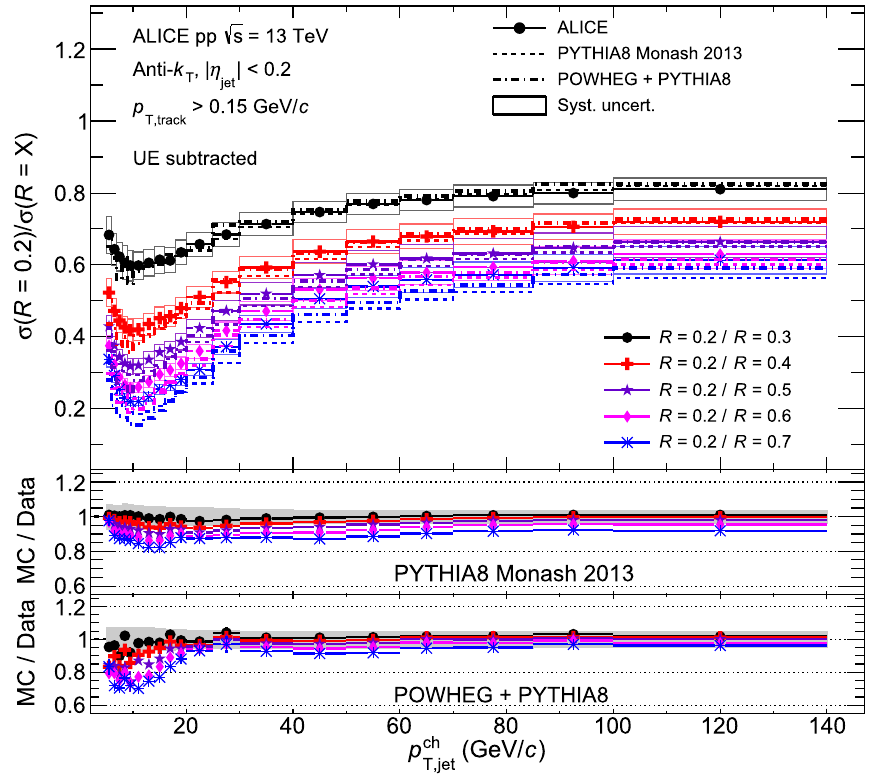
Fig. 5 Ratio of charged-particle jet cross section for resolution param- eter R = 0 . 2 to other radii R = X , with X ranging from 0 . 3 to 0 . 7, after UE subtraction. Data are compared with LO (PYTHIA) and NLO (POWHEG+PYTHIA8) predictions as shown inthe bottom panels. The